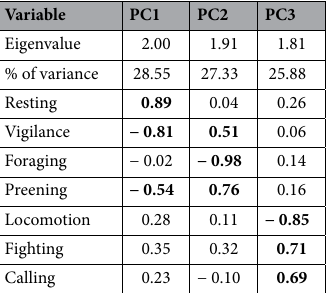
Table 2. Results of principal component analysis of seven behavioral variables obtained from 150 whooper swans. PC loadings >|0.50| are shown in bold font type.